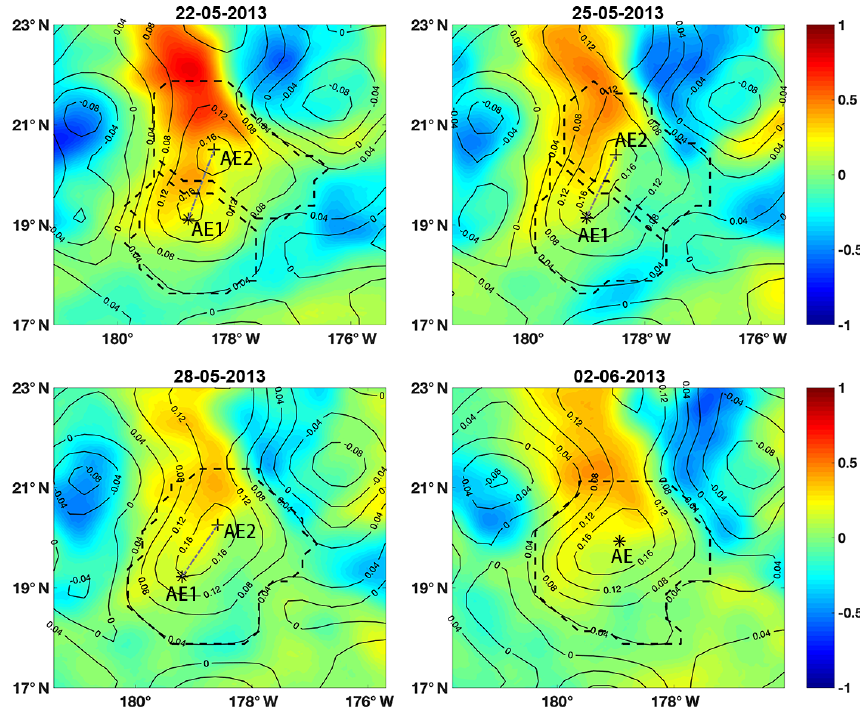
Figure 2. Merging event of surface anticyclonic eddies. The colors and contours represent SST and SLA values, respectively. The eddy boundaries are labeled with dashed curves. The cross and asterisk represent eddy centers identified by the fitting method. The dashed line connecting eddy centers rotates anticyclonically during the merging